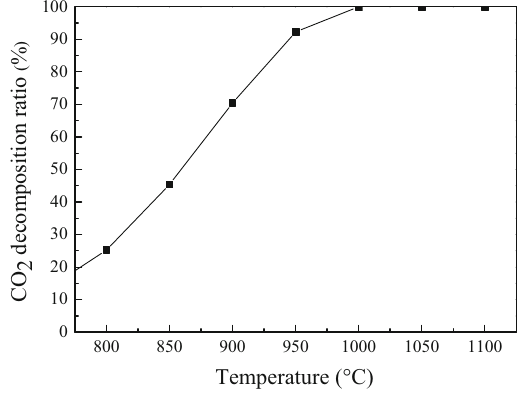
Fig. 2 CO 2 gasification reactivity of ZD coal